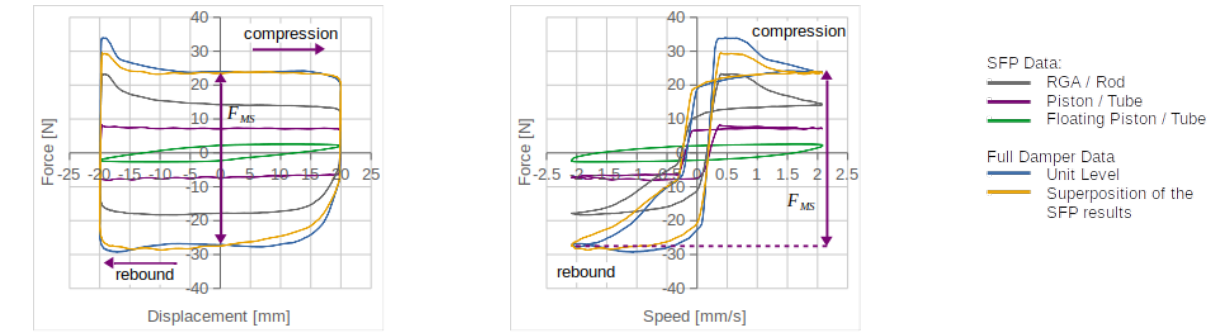
Figure 7. Comparison of the force displacement graphs ( left ) and the force speed graphs ( right ) of the take-apart full damper friction measurement and the superposition of the three single friction point measurements at the rod guide assembly/rod, piston/tube, and floating piston/tube.